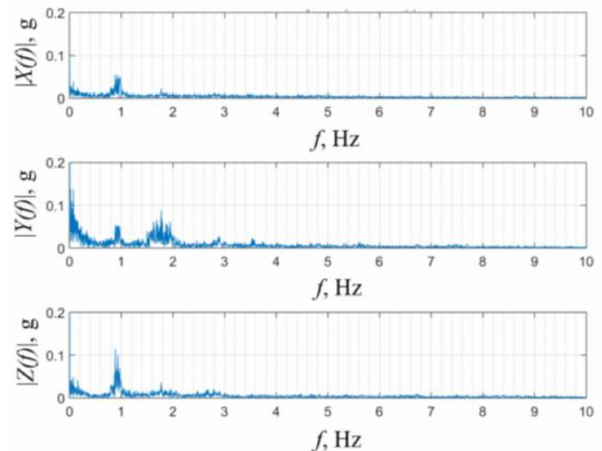
Figure 3. Accelerations during human walking in the frequency domain